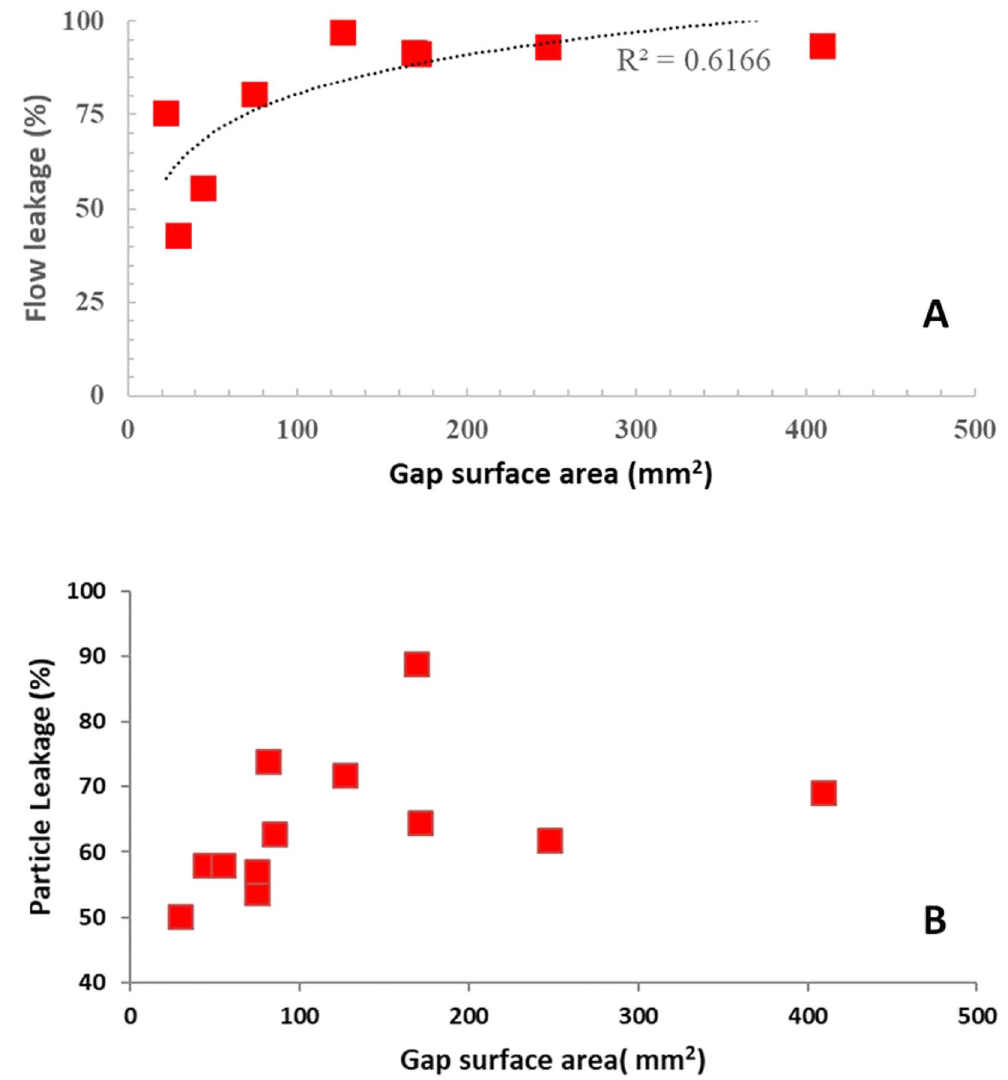
Figure 11. Variation of ( A ) flow and ( B ) particle leakage with gap surface area in mm 2 for breathing flow rate of 10 LPM (R 2 = 0.16 for linear